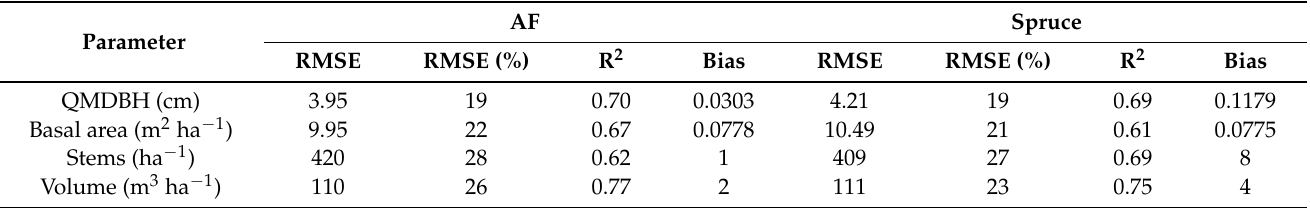
Table 6. Random Forest modelling results for all field plots (AF) and only using majority Spruce field plots (Spruce). AF Spruce Parameter